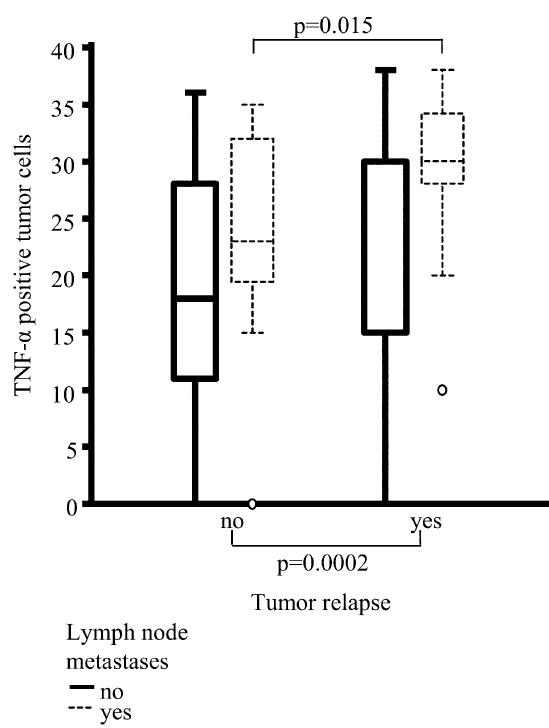
Fig. 6. High TNF- α expression is strongly associated with tumor recurrence in patients with positive lymph node metastases: Sig- nificant elevated TNF- α expression was found within patients of tumor recurrence compared to patients without tumor recurrence ( p = 0 . 0002). Subgroup analysis demonstrates a significantly ele- vated TNF- α expression in patients with tumor recurrence and pos- itive lymph node metastases compared to patients without tumor re- currence and positive lymph node metastases ( p = 0 . 015). No differ- ence of TNF- α expression is found by comparing TNF- α expression in patients with and without tumor recurrence and negative lymph node metastases.